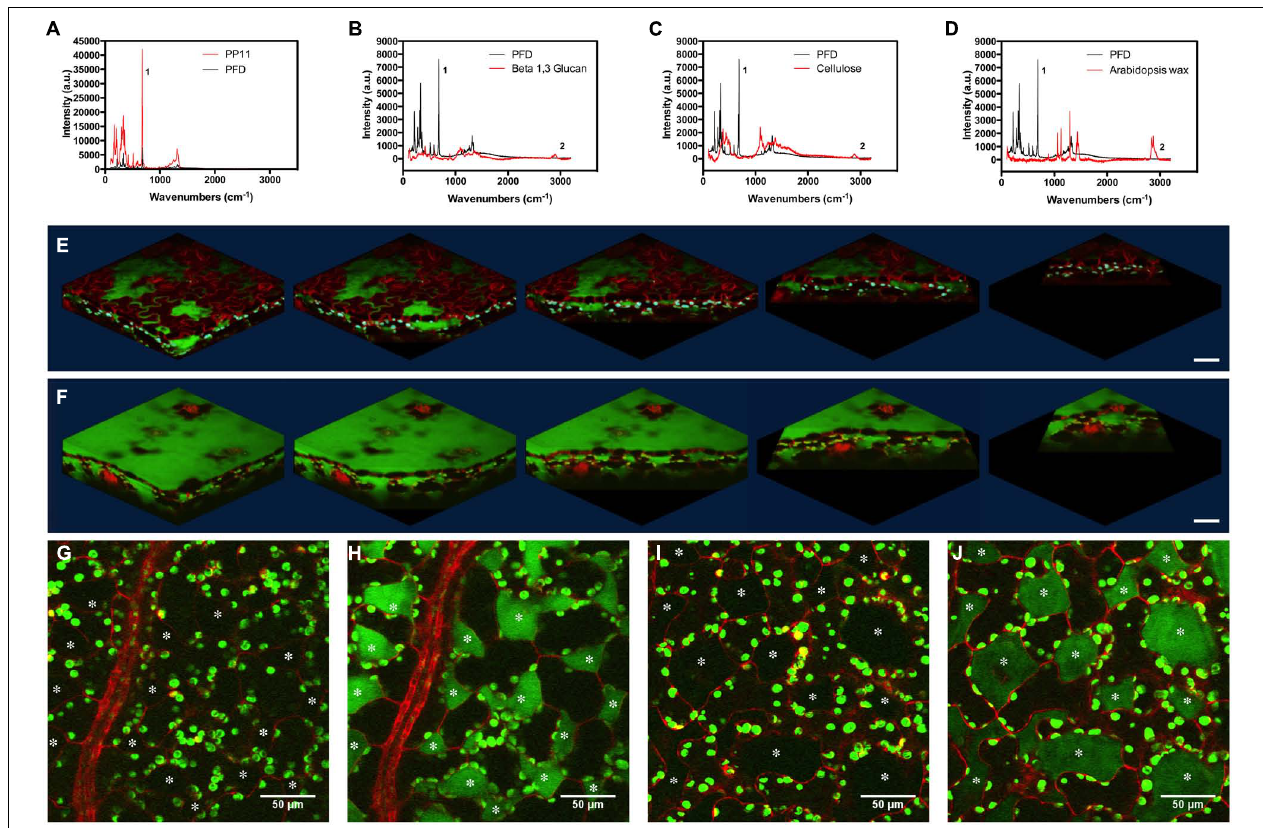
FIGURE 4 | Stimulated Raman scattering imaging of perfluorocarbons in vivo . (A–D) Raman spectra taken at 785 nm, comparing spectra of PFD and (A) PP11, (B) Beta 1–3 glucan, (C) cellulose, and (D) hexane extracted Arabidopsis leaf wax. Peaks labeled one and two were used to tune imaging to C–F and C–H bonds respectively. (E,F) SRS images representing